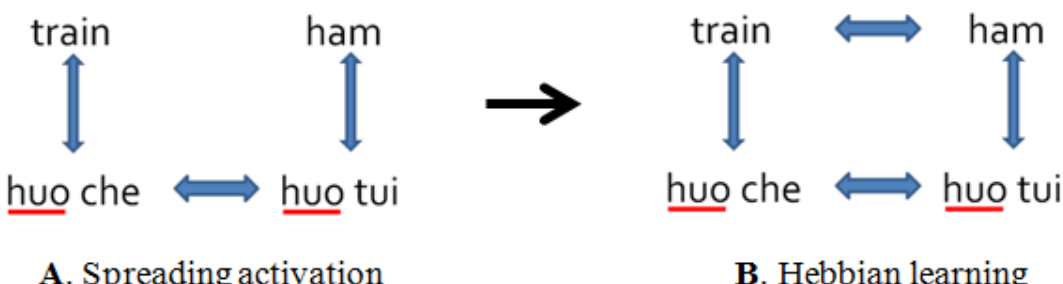
Figure 1. Development of the second language (L2) lexicon during L2 lexical acquisition as per Costa and colleagues [3]. ( A ) Spreading activation of four first language (L1) and L2 terms during L2 learning; ( B ) simultaneous activation of all four terms due to Hebbian learning.